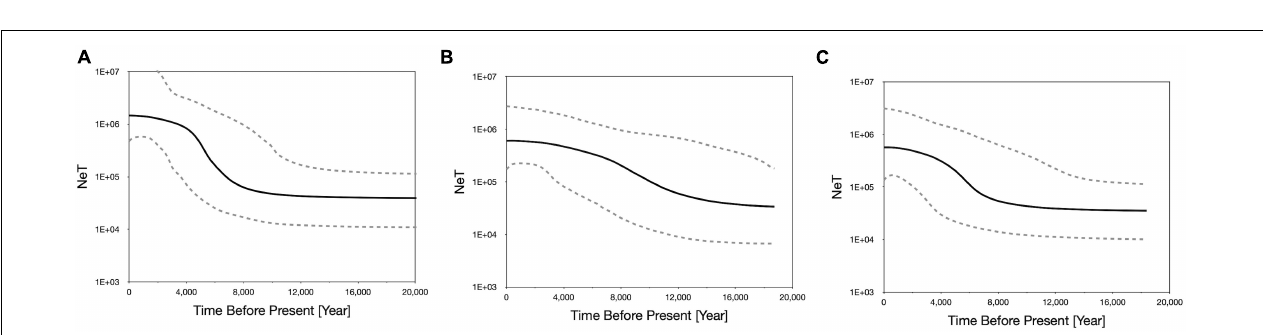
FIGURE 4 | Bayesian skyline plotting of (A) overall Eriphia ferox under investigation; Eriphia ferox populations in (B) Taiwan (Mainland), (C) Taiwan (Penghu). The y-axis refers to the product of effective population size (N e ) and generation time (T). The black line represents the median estimate, and the two dashed lines bound the 95% highest posterior density (HPD)